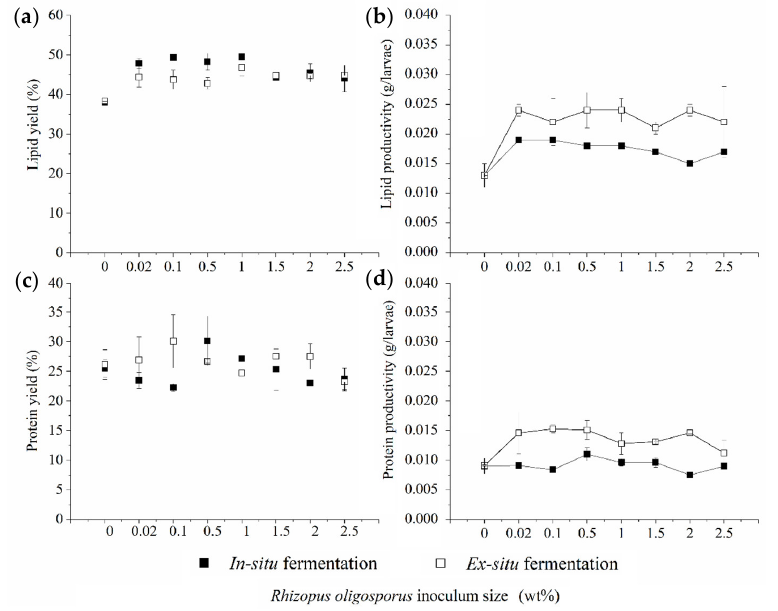
Figure 3. Yields and productivities for each lipid (( a ) and ( b ), respectively) and protein (( c ) and ( d ), respectively) derived from BSFL upon feeding with in situ- and ex situ-fermented CEW. In the case of the larval lipid productivities derived from in situ fermentation, there were significant differences ( p < 0.05) among various inoculum sizes—namely, 0.02 wt% and 0.1 wt% as well as 0.5 wt% to 2.5 wt% had similar impacts. Nevertheless, the ex situ fermentation was later noticed to perform better than the in situ fermentation in terms of lipid productivity. In terms of statistics, the significant difference was found to be incon- spicuous ( p > 0.05) among the various inoculum sizes of R. oligosporus for lipid productiv- ities derived from ex situ fermentation. Thereby, for any instance, the use of ex situ - fer- mented CEW could give rise to at least 20–60% higher lipid productivities than the in situ - fermented CEW for the similar inoculum sizes studied. The higher lipid productivities were primarily attributed to the higher biomass values gained and the growth rates of BSFL (Figure 1) administered with various inoculum sizes of R. oligosporus to carry out ex situ fermentation. In order to attain lipid-rich BSFL, it was suggested that 1.0 wt% of R. oligosporus should be introduced into CEW and treated by means of ex situ fermentation. As compared with other exo-microbial fermentations, it was found that the highest lipid yield (49%) was also obtained with 1.0 wt% yeast via in situ fermentation (Wong et al.,